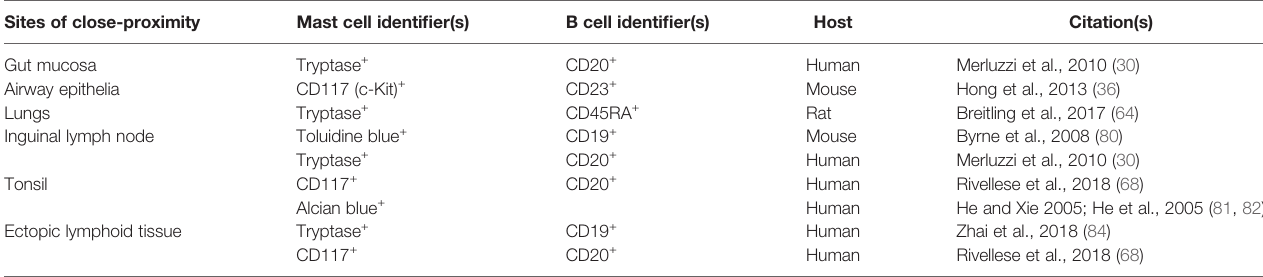
TABLE 1 | Sites of close-proximity between mast cells and B cells in multiple